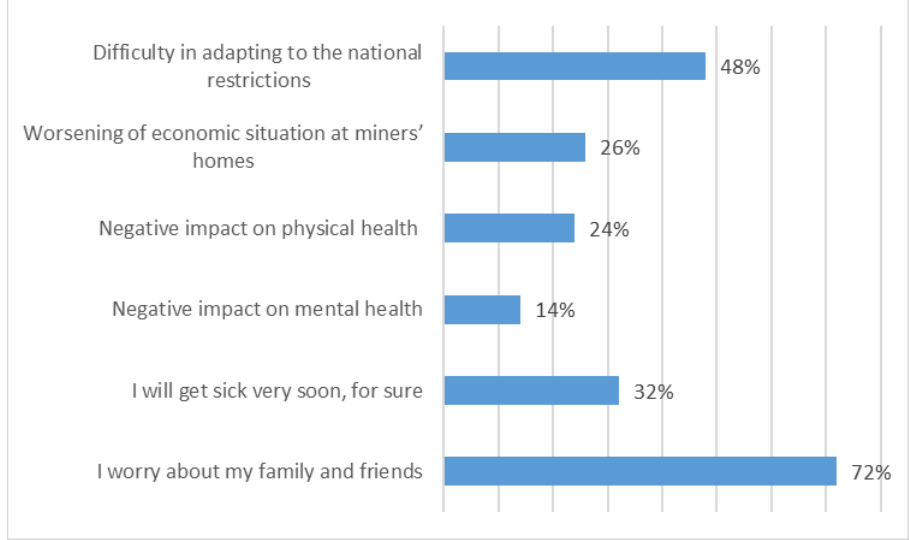
Figure 8. Impact of the pandemic through the eyes of miners. Own study based on [49]. The high percentage of those worried about their families shows how respondents complied with the restriction at the mining plants (Figure 9). All stayed away from others by observing to keep a safe distance. Almost all, 98%, stayed at home, choosing to take an overdue holiday to avoid contact with others and thus reduce the risk of illness. 86% use disinfectants and 42% use face masks.